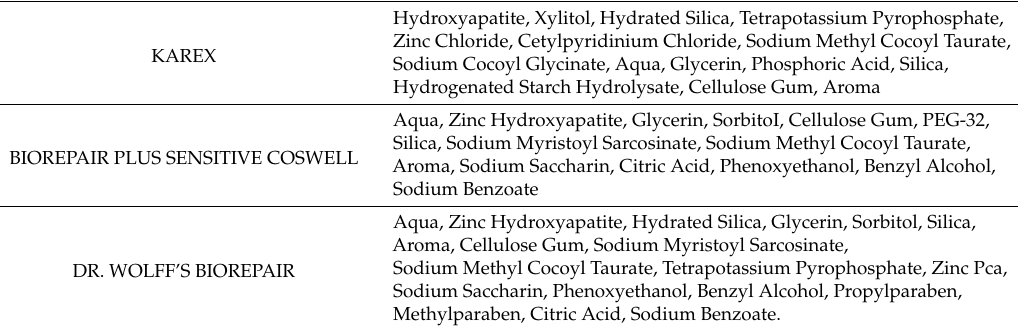
Table 1. Chemical ingredients of the desensitizing